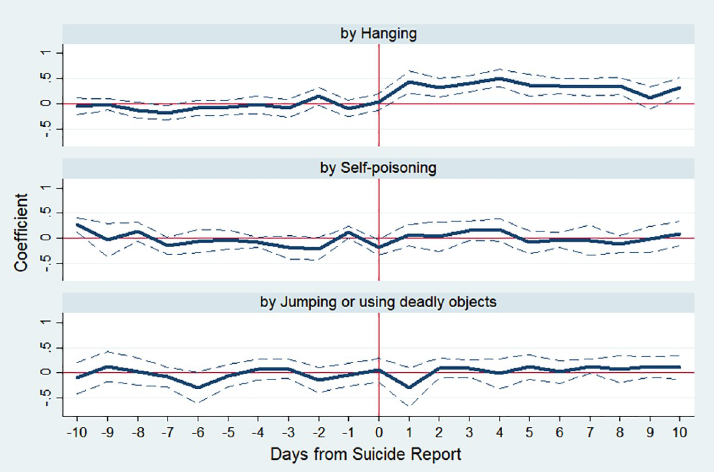
Fig 6. Estimated changes in total suicides by suicidal method before and after media reports on celebrity who committed suicide by hanging. Note: The y -axis indicates an approximate percent change in public suicide by corresponding day, which is the estimated β k in Eq (1). The dotted lines indicate 95% confidence